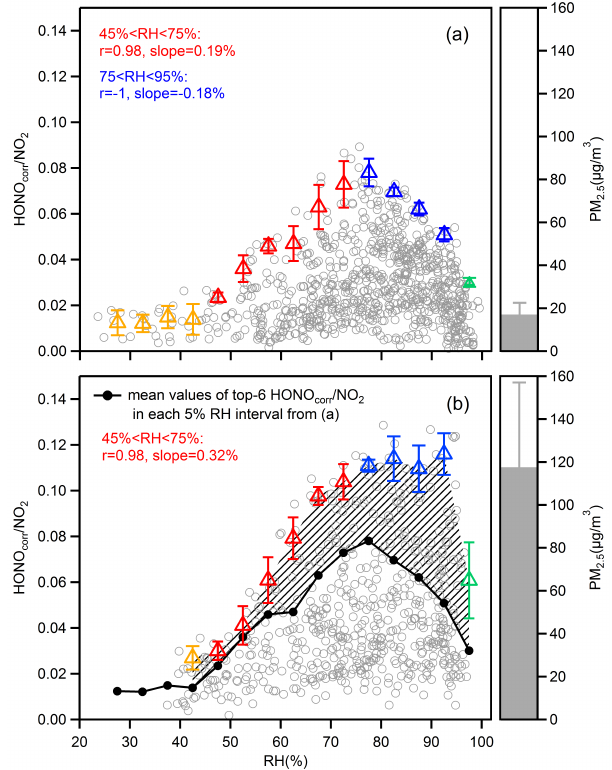
Figure 6. Scatter plots of the HONO corr / NO 2 ratio and RH during nighttime, separating the data into (a) clean hours (hourly mean PM 2 . 5 <25µgm − 3 ) and (b) polluted hours (hourly mean PM 2 . 5 >75µgm − 3 ). Triangles are the averaged top-six HONO corr / NO 2 in each 5% RH interval, and the error bars are the standard deviations. The overall average concentrations of PM 2 . 5 in (a) and (b) are shown to the right of the